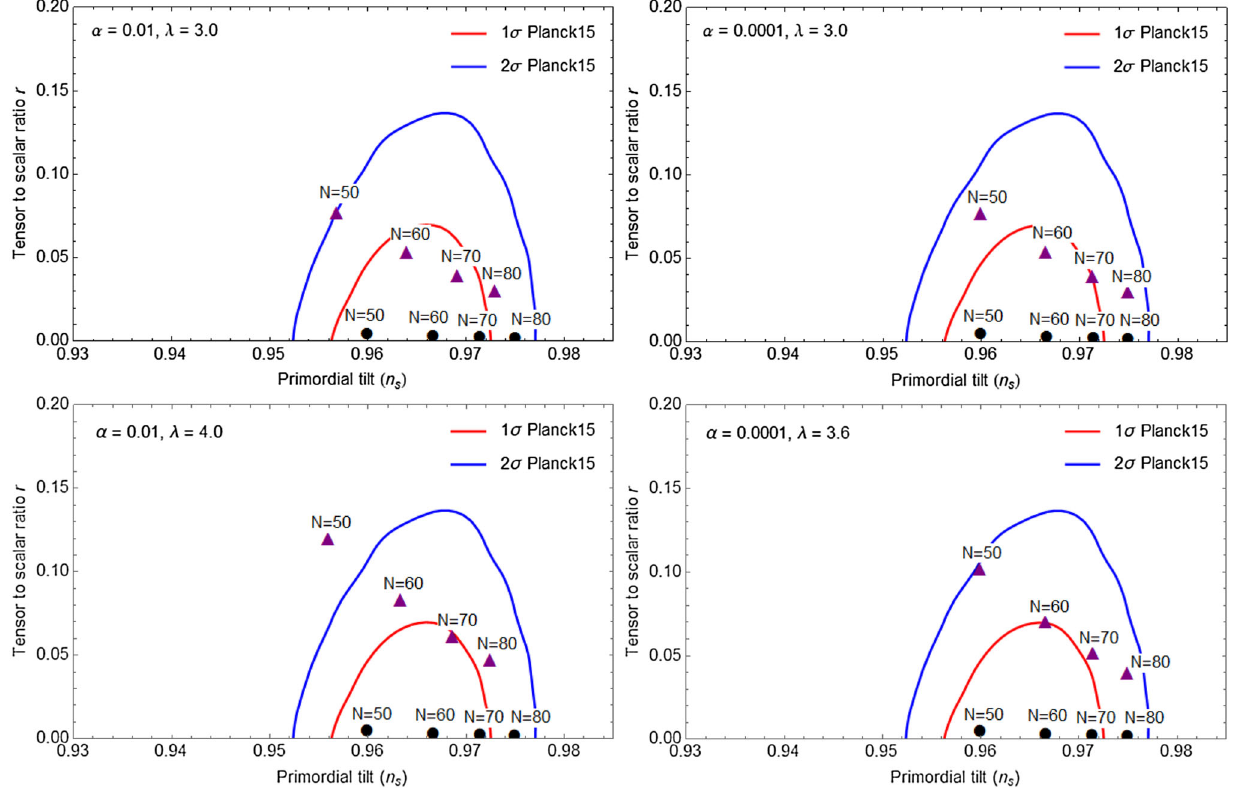
Fig. 2 We compare the theoretical predictions in the ( r − n s ) plane for different values of N using α = 0 . 01 , λ = 3 . 0 (uper-left panel); α = 0 . 0001 , λ = 3 . 0 (uper-rightpanel); α = 0 . 01 , λ = 5 . 0 (lower-left